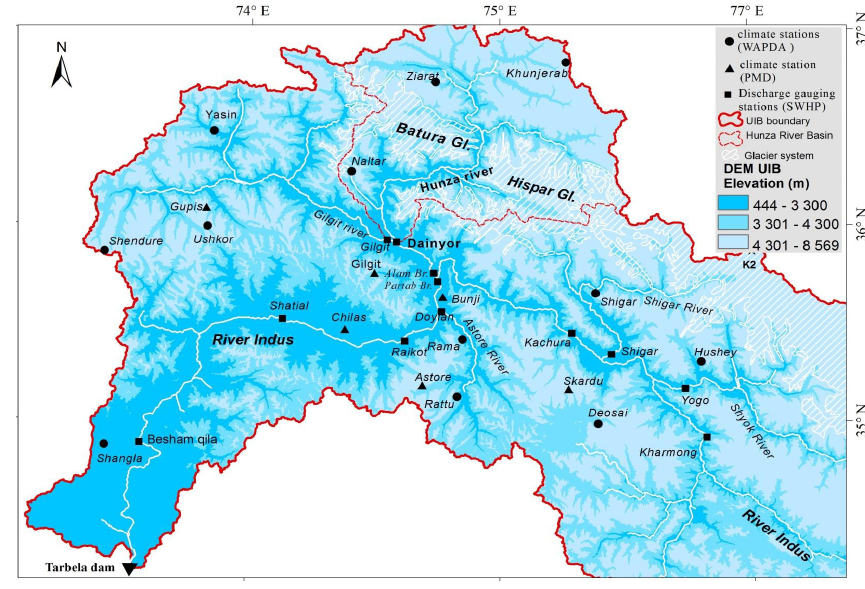
Fig. 2. ASTER Global digital elevation model (GDEM) of the Upper Indus River Basin and gauging station network within the boundary of Pakistan (Hunza River catchment location in the UIB is shown with a thin boundary line). The projection of the map is WGS1984 UTM 43N.